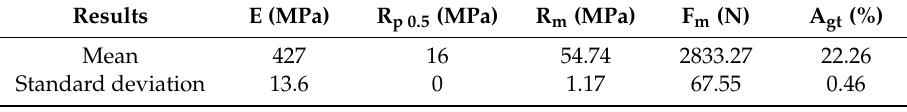
Table 5. Results for mechanical properties (DIN EN 10002-1) of reference samples.